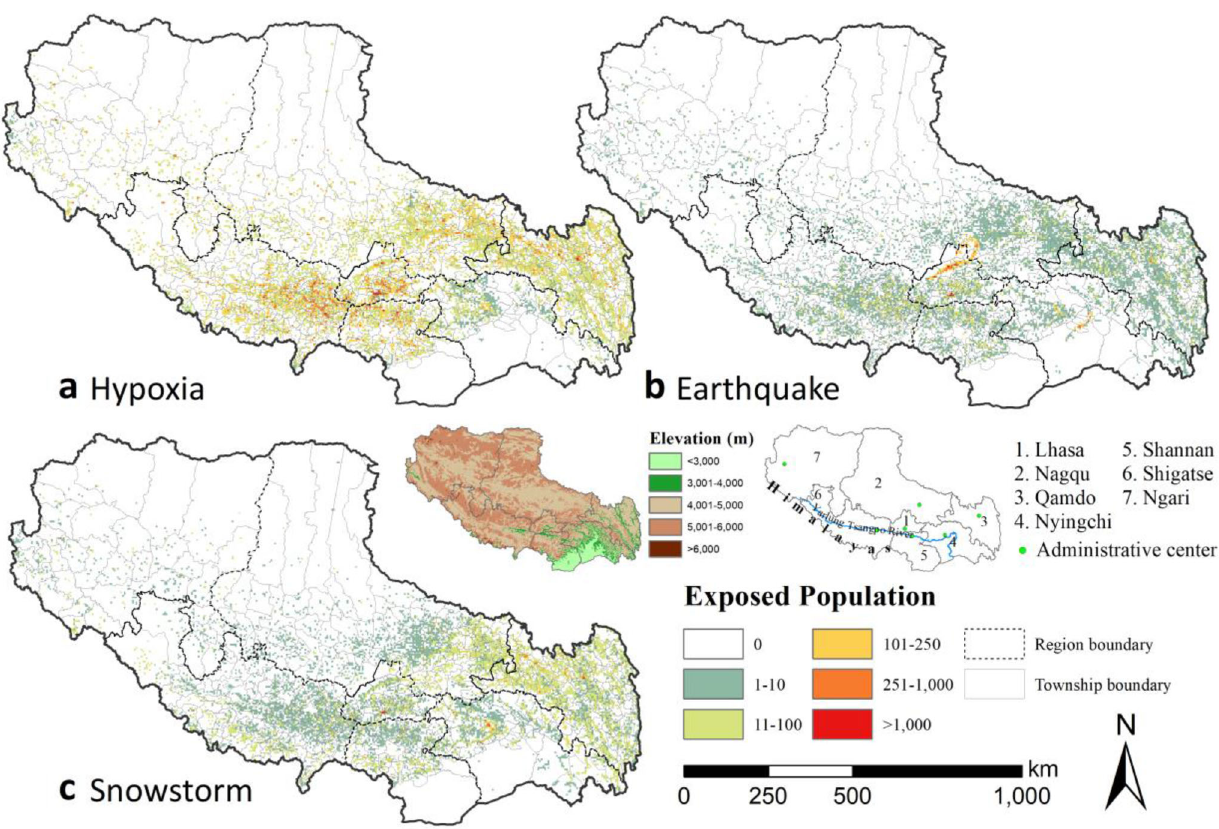
Fig. 2 Spatial distributions of population exposure to single hazards in Tibet: a hypoxia, b earthquakes, and c snowstorms, 2015